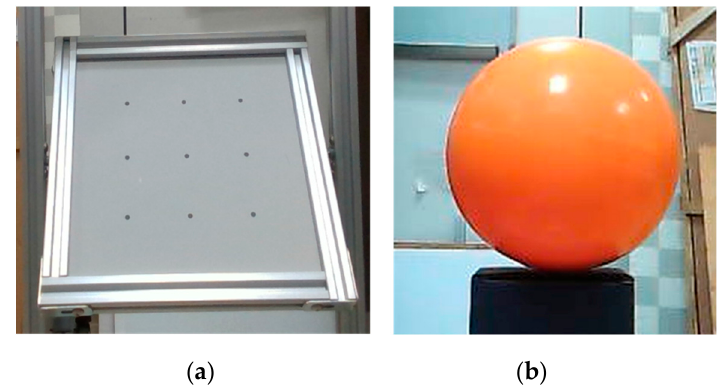
Figure 11. Reference objects for accuracy evaluation: ( a ) standard plane and ( b ) standard sphere.